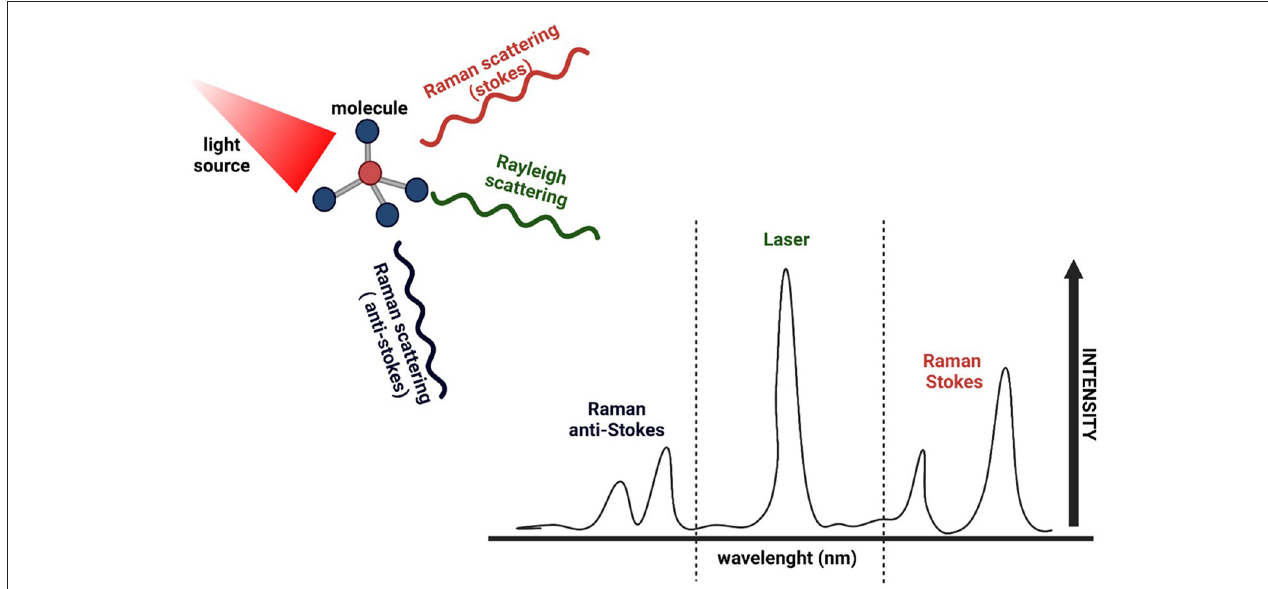
FIGURE 2 | Schematic representation of Raman spectroscopy. After the sample (molecule) is exposed to an intense beam of monochromatic light in the frequency range of visible, near-infrared or near-ultraviolet region, most of the scattered light is at the same wavelength as the laser source (Rayleigh scattering). In contrast, a small amount of light is scattered at different wavelengths depending on the chemical structure of the analyte (Raman scattering). A Raman spectrum is a vibrational spectrum, where each peak corresponds to a specific molecular bond vibration, showing the intensity and wavelength position of the Raman scattered light.